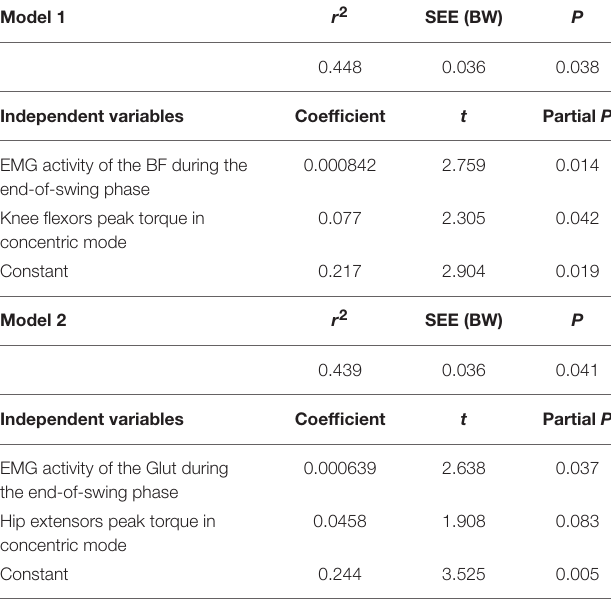
TABLE 4 | Multiple linear regression analysis for horizontal ground reaction force (in BW) averaged over the first 10 steps (initial acceleration phase, dependent variable in both models), n = 14